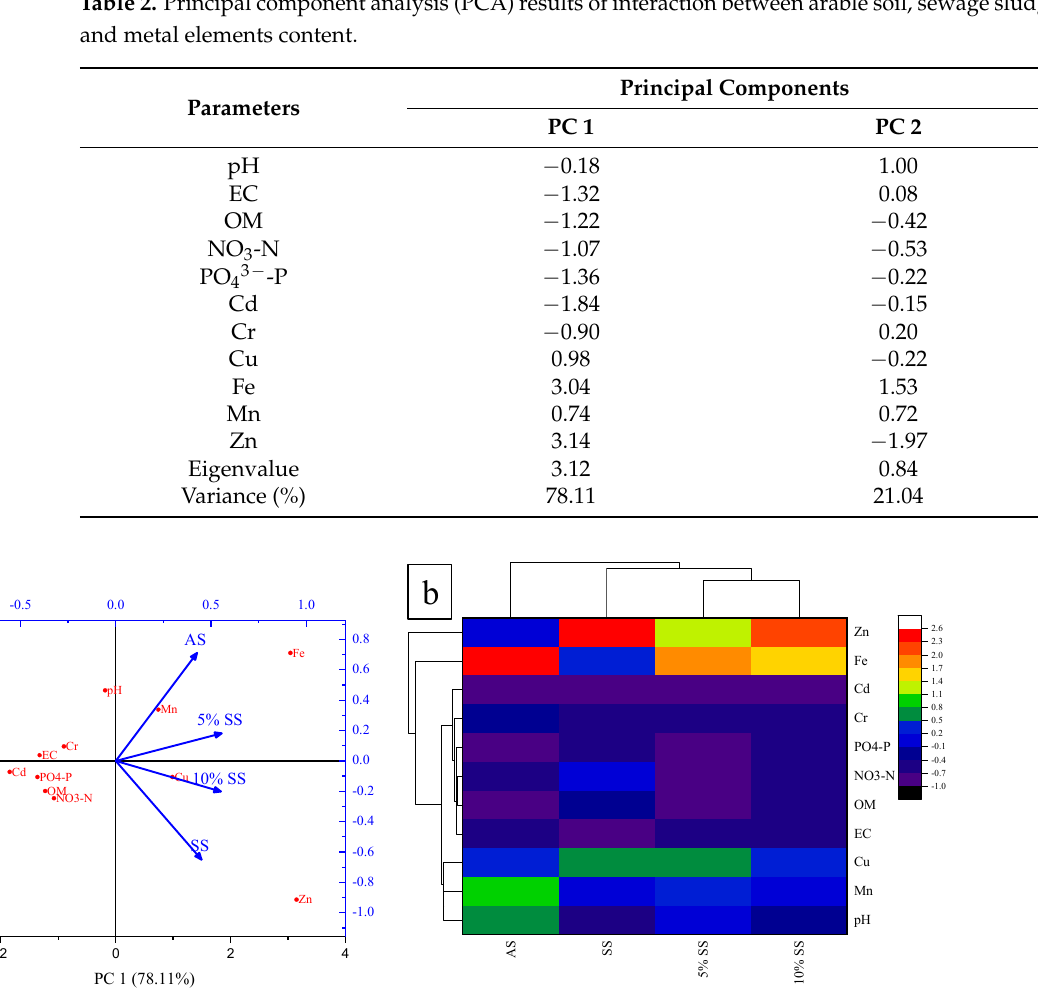
Figure 2. ( a ) PCA biplot and ( b ) clustered heatmap for the interaction of sewage sludge (SS) on soil nutrient availability. Table 1. Soil properties (mean ± standard deviation, n = 3) used for Ridge gourd ( L. acutangula ) cultivation under different sewage sludge and plant growth-promoting rhizobia (PGPR) treatments.